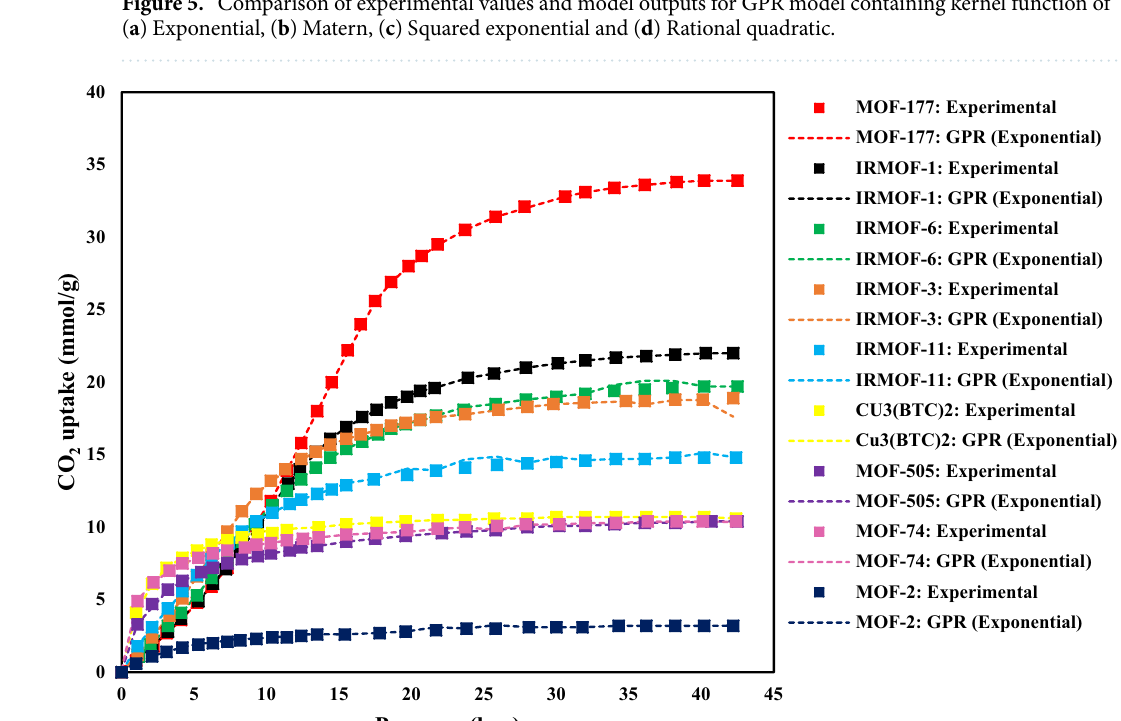
Figure 5. Comparison of experimental values and model outputs for GPR model containing kernel function of ( a ) Exponential, ( b ) Matern, ( c ) Squared exponential and ( d ) Rational quadratic.